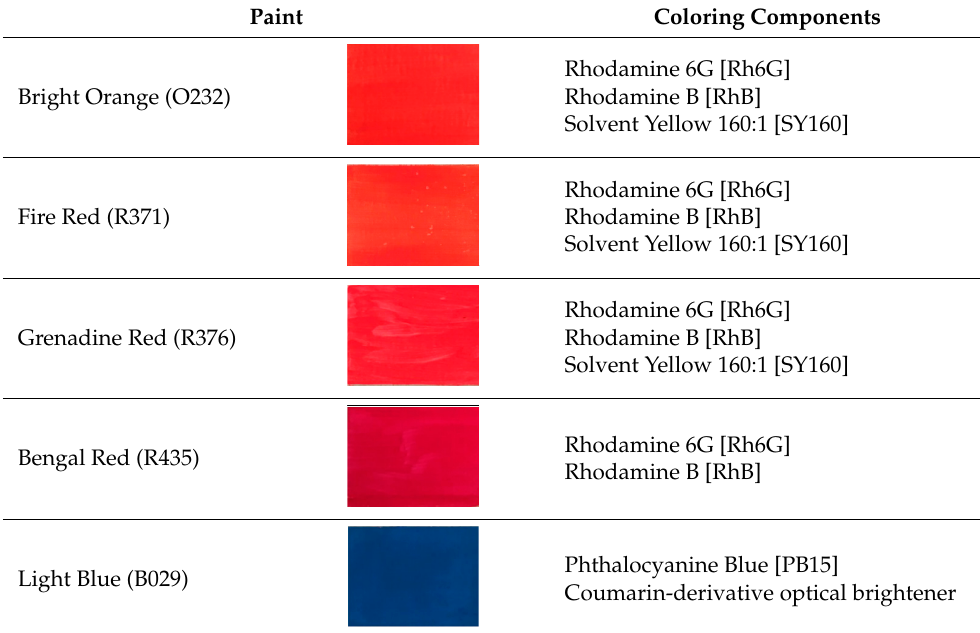
Table 1. Cont. Paint Coloring Components